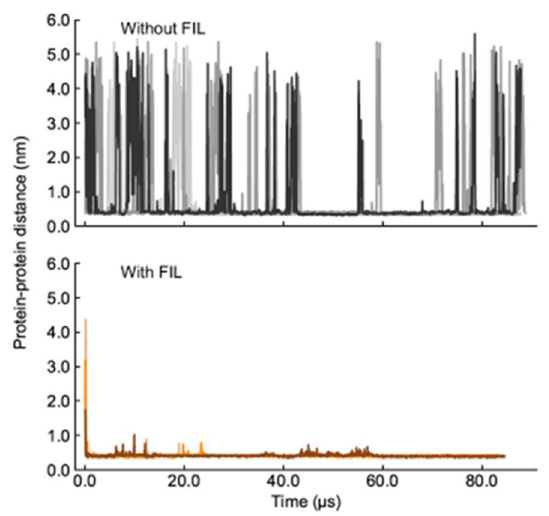
Figure 6. Lys–Lys contacts over time in the absence ( top ) and presence ( bottom ) of [N 1112(OH) ][C 4 F 9 SO 3 ].